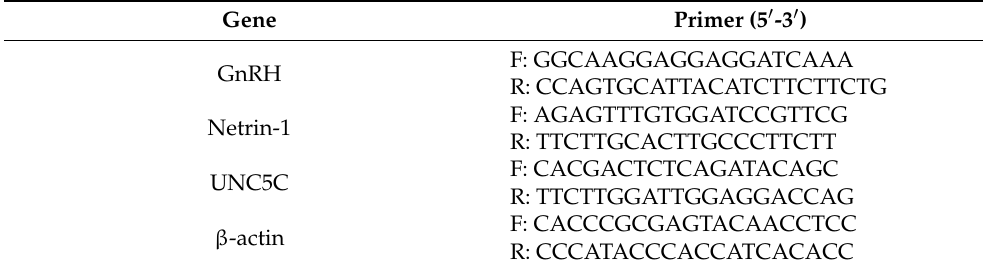
Table 3. List of primers used in real-time